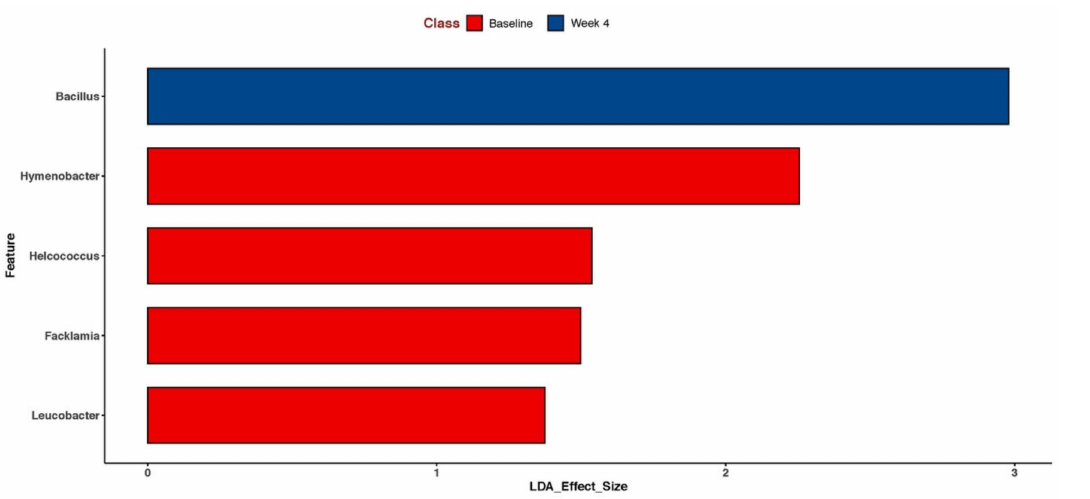
Figure 7. Stacked bar plots of the skin microbiome after 4 weeks of supplementation in the placebo and PE group. The skin microbiome was collected through the use of facial skin swabs.